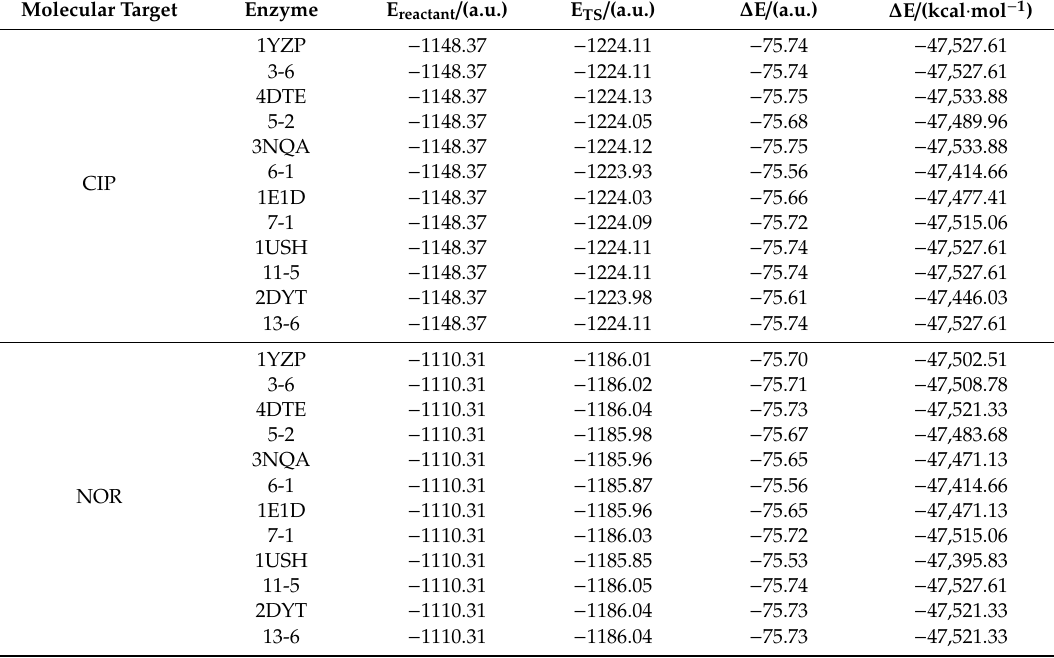
Energy barrier calculation of degradation reaction between novel enzymes and target